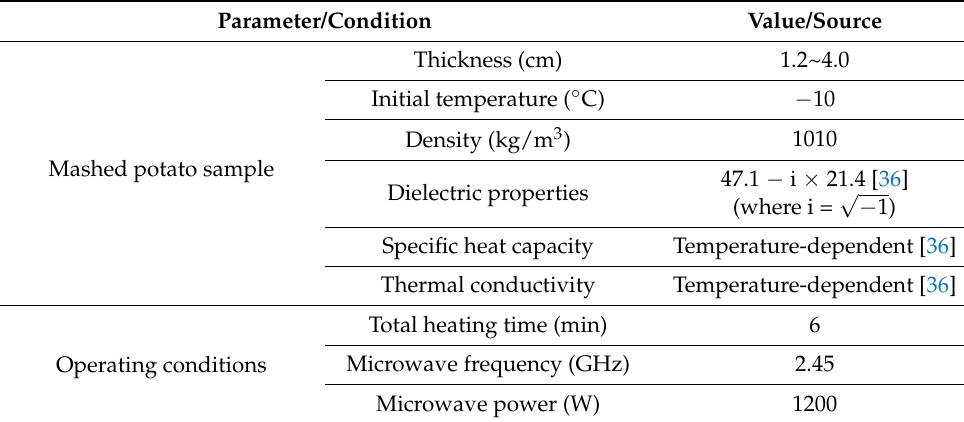
Figure 2. Flow chart of the microwave heating simulation based on the strategy with discrete rotation and decoupled approach of electromagnetic (EM) field and heat transfer. Table 1. Parameters and conditions in mechanistic-modeling of microwave